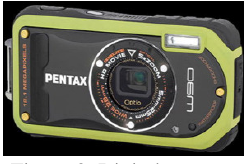
Figure 3. Digital